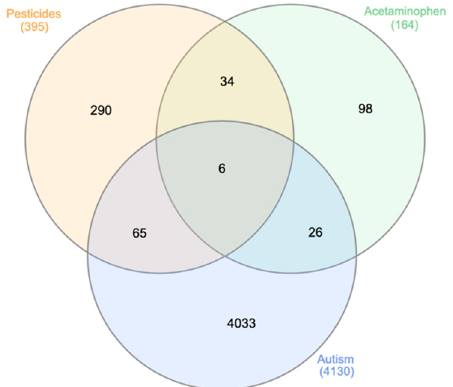
Figure 1. Venn diagram for overlapping genes associated with APAP, pesticides and ASD. The diagram shows the number of genes associated with APAP, pesticides, or ASD, or jointly with any two or all three factors. Six genes overlapped in all three categories: ABCB1 , ABCB4 , CYP1A2 , CYP3A4 , FAS , and IGF1R . These six genes were used for pathway analysis in IPA. The 65 genes found to overlap between the pesticide and ASD nodes, as well as the 26 genes overlapping be- tween the APAP and ASD nodes, are listed in Appendix C. APAP and ASD nodes, are listed in Appendix C.